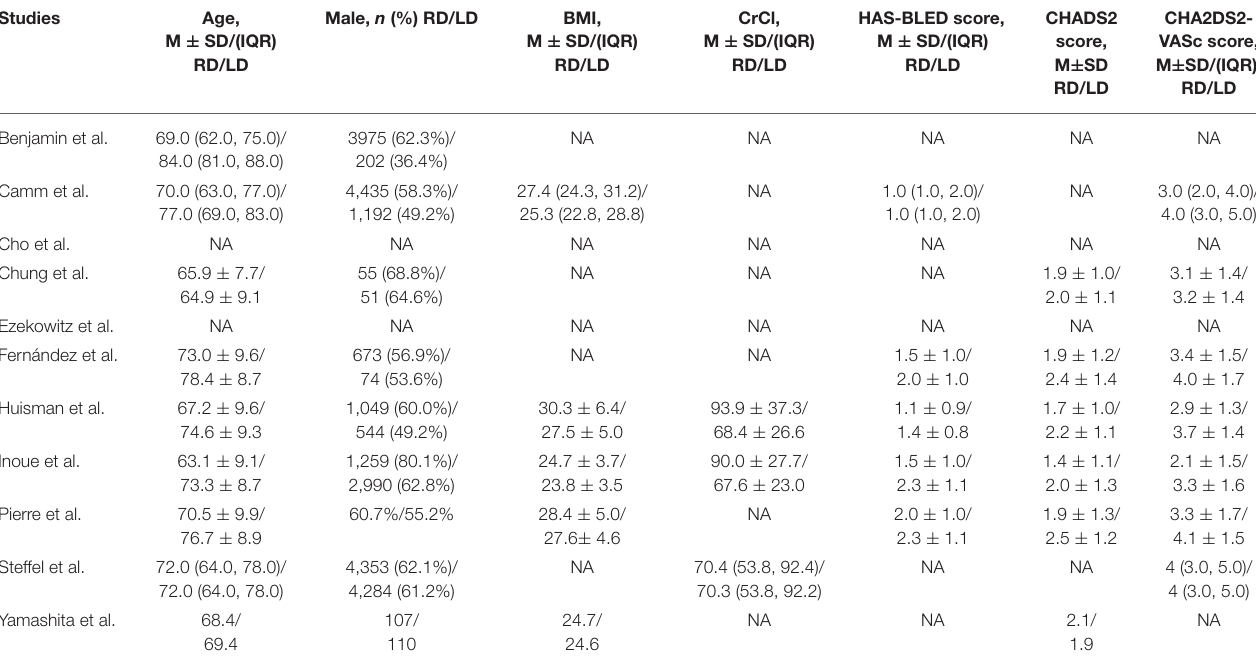
TABLE 4 | Baseline characteristics of recommended dose and non-recommended low dose of NOACs. Studies HAS-BLED score,